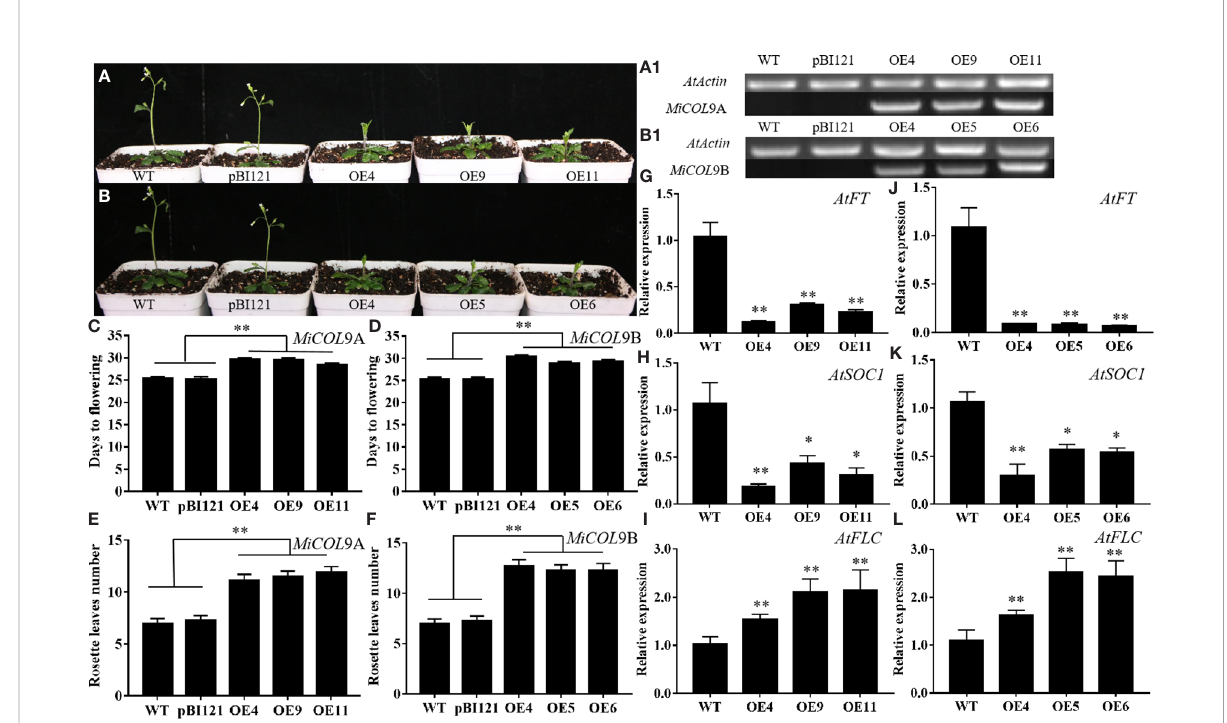
FIGURE 8 Ectopic expression of MiCOL9A and MiCOL9B delays fl owering under LD conditions. (A, B) Phenotype of transgenic Arabidopsis plants under LD conditions. (A1, B1) sqRT-PCR of MiCOL9A and MiCOL9B in the WT, pBI121 and transgenic plants. (C, D) Flowering times. (E, F) Rosette leaf numbers. (G-I) Expression levels of AtFT , AtSOC1 and AtFLC in MiCOL9A (G-I) and MiCOL9B (J-L) transgenic lines. Signi fi cant differences were assessed at p < 0.05 (*) and p < 0.01 (**) levels by Student ’ s t